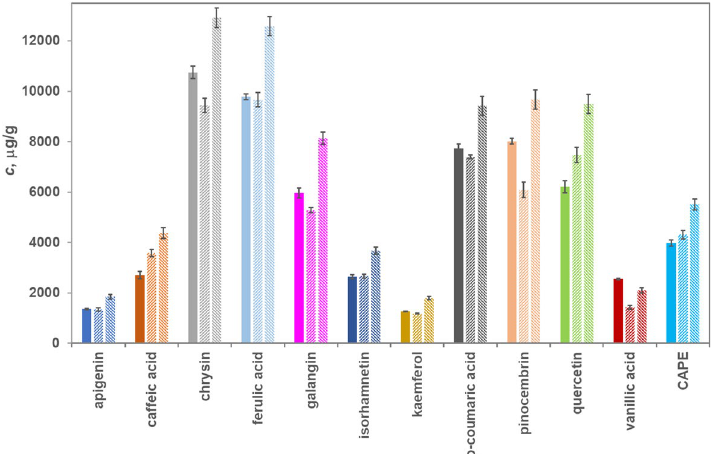
Figure 2. Polyphenolic derivatives composition pattern at different liquid : solid ratios in 50% ethanol (EE25 – full colour, EE45 – diagonal stripes upward, and EE65 – diagonal stripes